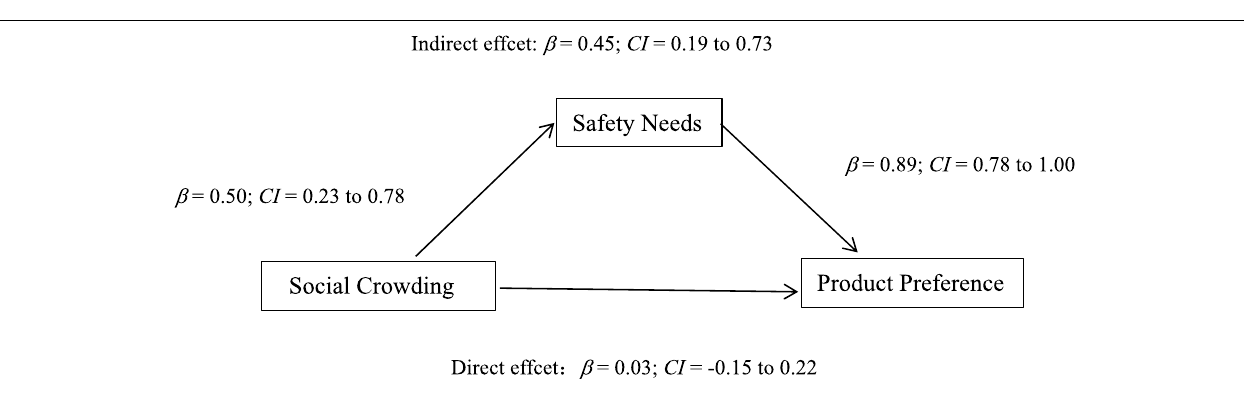
FIGURE 3 | (A) “Ferma” is a very famous natural shampoo product. It extracts pure natural plant essence without addition, safe and reliable. It can deeply clean the scalp, solve a variety of hair problems, and protect your soft hair. (B) “Ferma” is a very famous original shampoo product. Its texture is mild and its foam is rich. It can deeply clean the scalp, solve a variety of hair problems, and protect your soft hair.